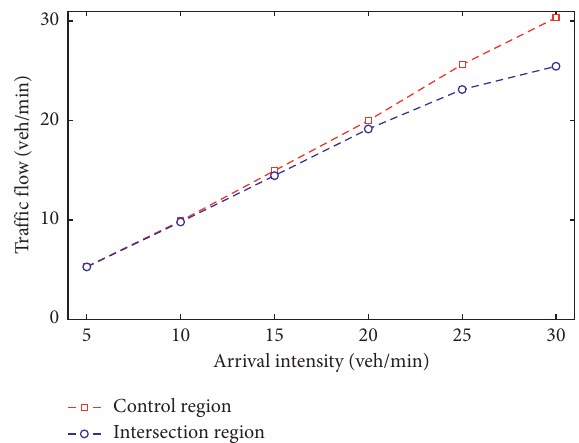
Figure 16: Second case study: average traffic flow at the entry and exit of the CR, respectively, for varying values of the arrival in- tensity, λ